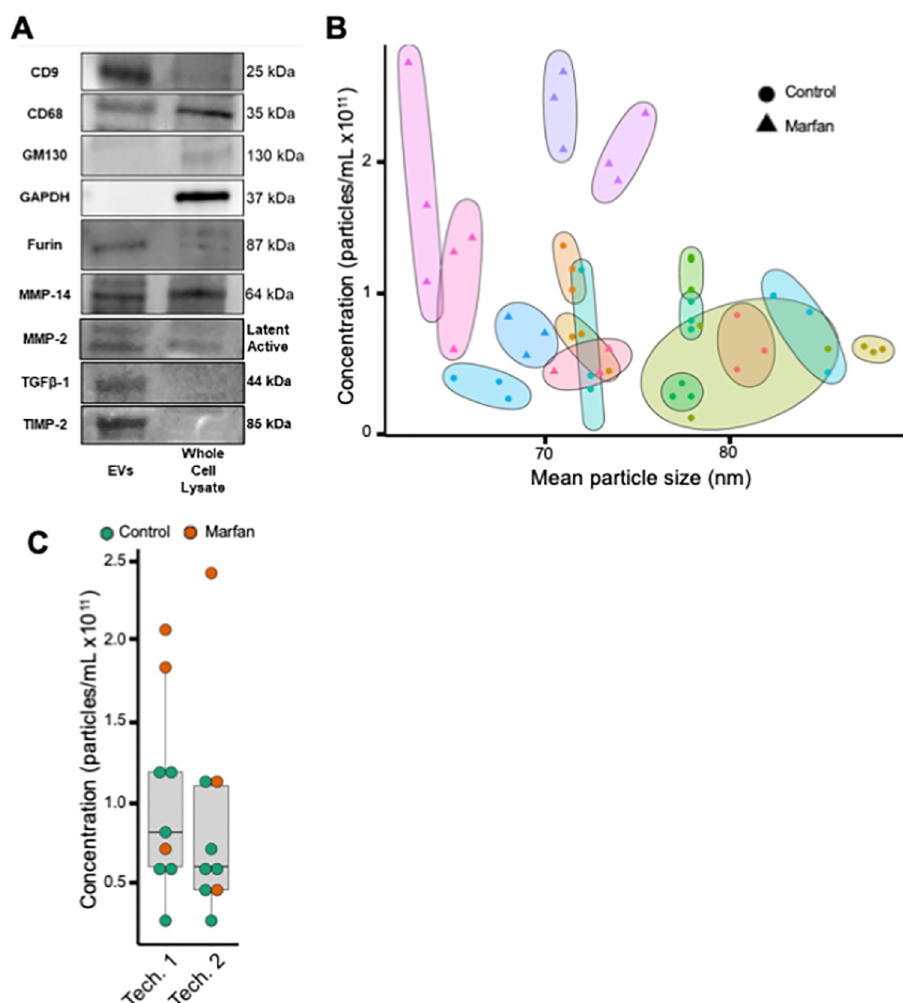
Fig 1. EV isolation and technical reproducibility following SEC isolation and TRPS measurement. (A) Western blot comparing prototypical markers and investigational targets in isolated EVs and whole cell lysate from HT1080 cells. (B) Dot plot comparing mean particle size (x-axis) and EV concentration (y-axis) among technical replicates of human plasma. Technical replicates are grouped by color and a correspondingly shaded ellipse. (C) Comparison of sample concentration (y-axis) by technician operating the TRPS instrument. EV concentration detected by technician 1 (median 0.81 x 10 11 particles/mL, interquartile range 0.59–1.19 x 10 11 particles/mL) and technician 2 (median 0.60 x 10 11 particles/mL, interquartile range 0.45–1.10 x 10 11 particles/mL, p = 0.606) are displayed separately. A Student’s t- test was used to test for significance.